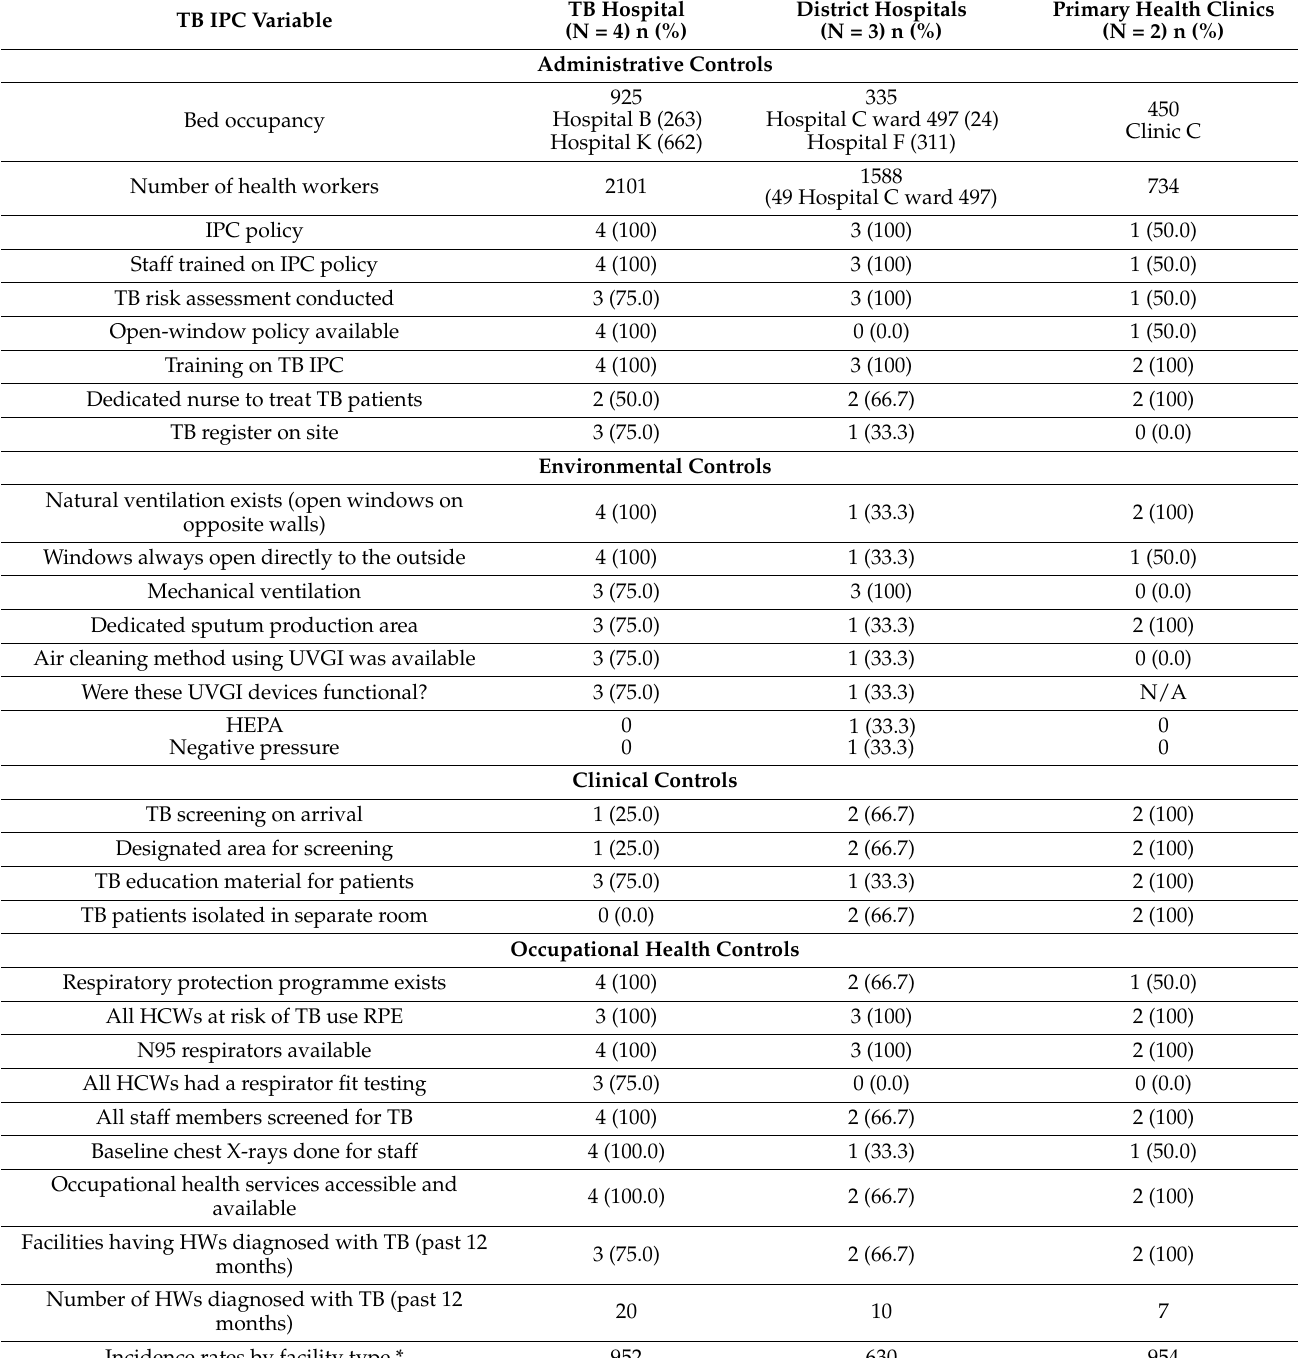
Table 1. Elements of tuberculosis infection prevention and control by healthcare facility